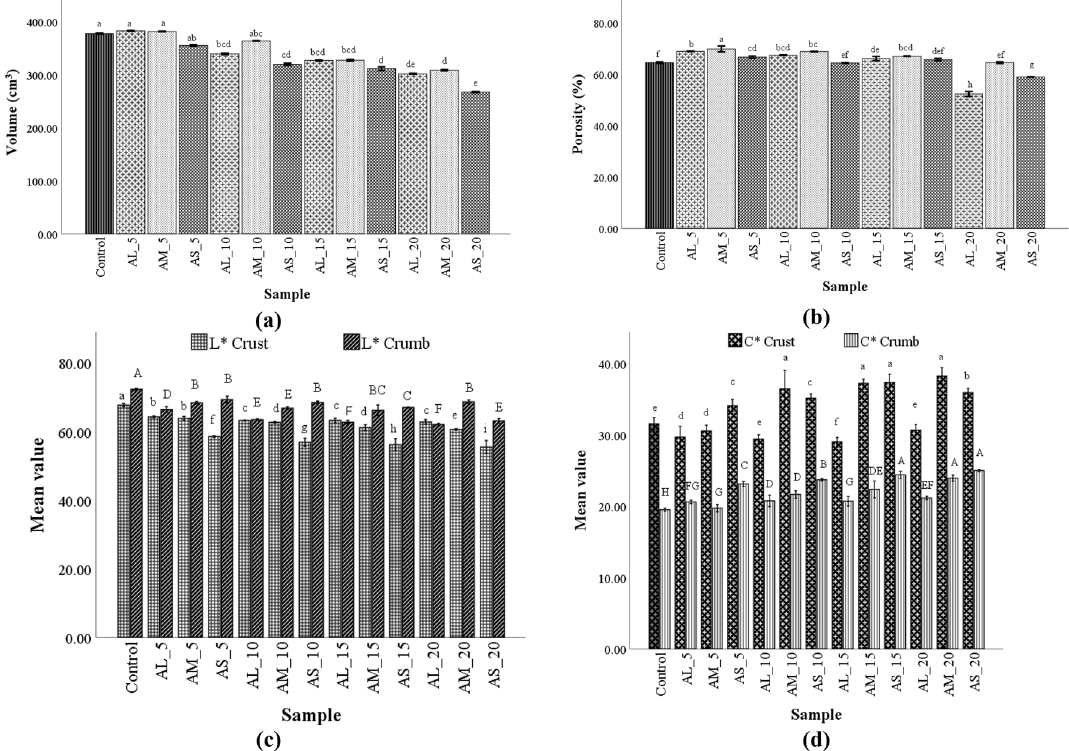
Figure 4. Physical and color parameters of bread samples with different amaranth flour particle sizes large (AL), medium (AM), and small (AS) and wheat flour replacement levels (5, 10, 15 and 20%); Means in the same column with different letters indicate significantly difference (P < 0.05): ( a – e ) for bread volume, porosity, and L*, C* Crust; and A–H for L* and C* Crumb. L*— Lightness; C*—